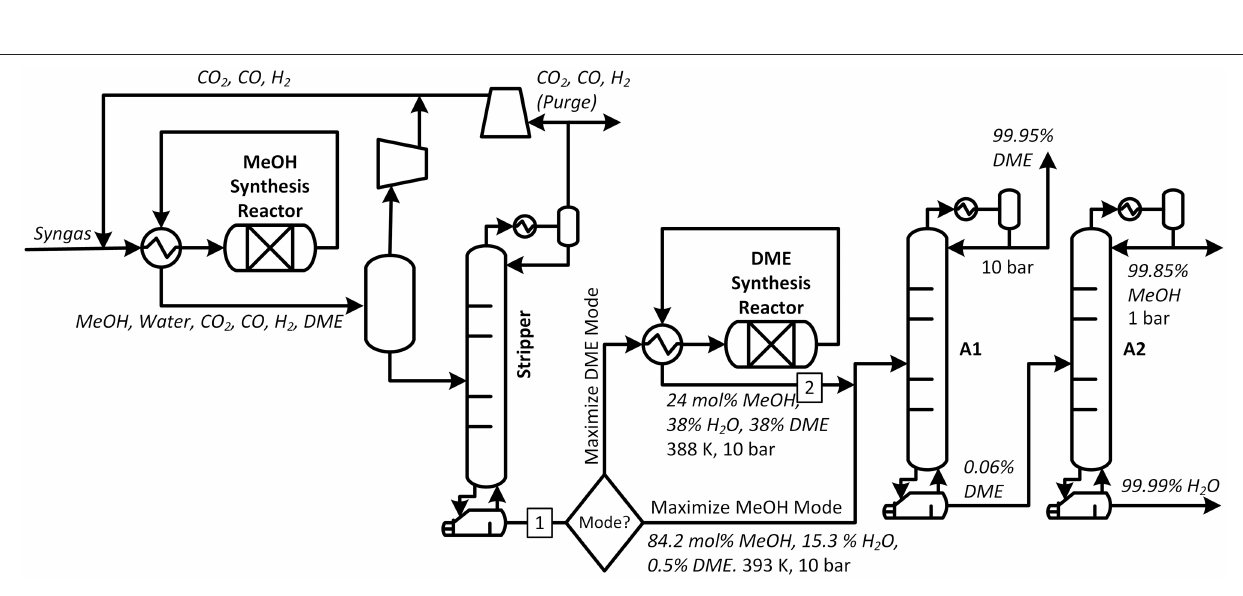
FIGURE 2 | Process overview for Flexible Design A design. In this system, syngas produces methanol (as well as DME, Water, and gaseous by-products) at steady state. During operation, the system can either be switched into Maximize DME Mode or Maximize Methanol Mode, but the same two distillation columns are used in either